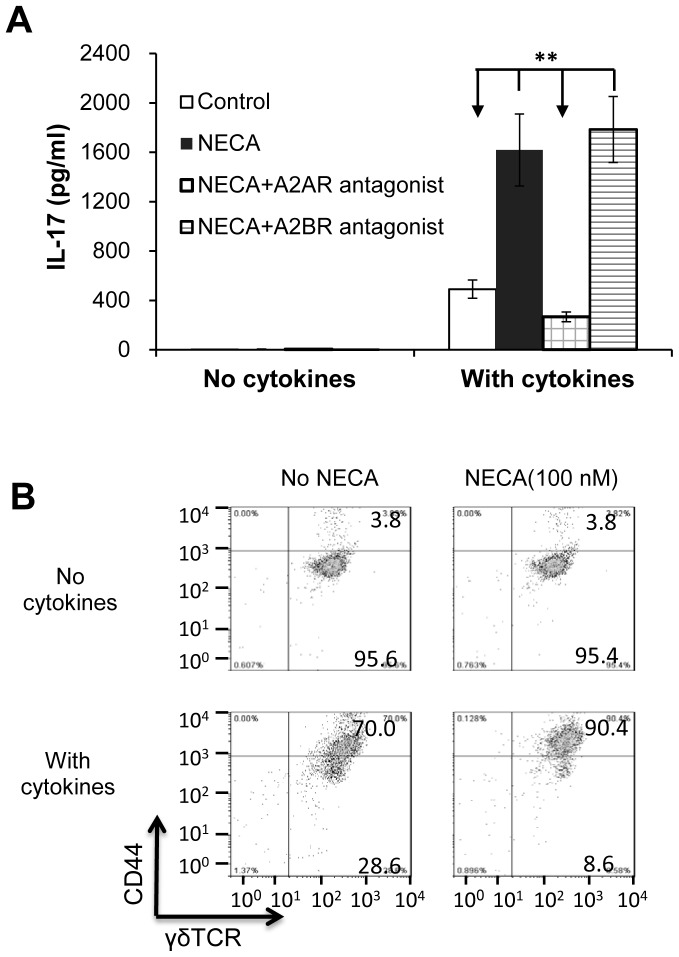
A2AR signaling enhances γδ T cell activation by a cytokine mixture.IL-17 production by γδ T cells. γδ T cells purified from immunized B6 mice (see M&M) were rested by incubating in cytokine-free medium for 5–7 days before testing. In 24-well plate, 2×105 γδ T cells were incubated 48h alone (Control) or with NECA (100 nM) with or without the A2AR or A2BR antagonist (100 nM) in the absence (left panel) or presence (right panel) of the cytokine mixture (IL-1, IL-7, and IL-23). **, p<0.01. Surface staining for the T cell activation marker CD44 showing that rested γδ T cells express low amounts of CD44, which is significantly increased by incubation 48h with the cytokine mixture and further increased when γδ T cells are exposed to cytokines in the presence of NECA. The results shown are from a single experiment and are representative of those obtained in >5 experiments.